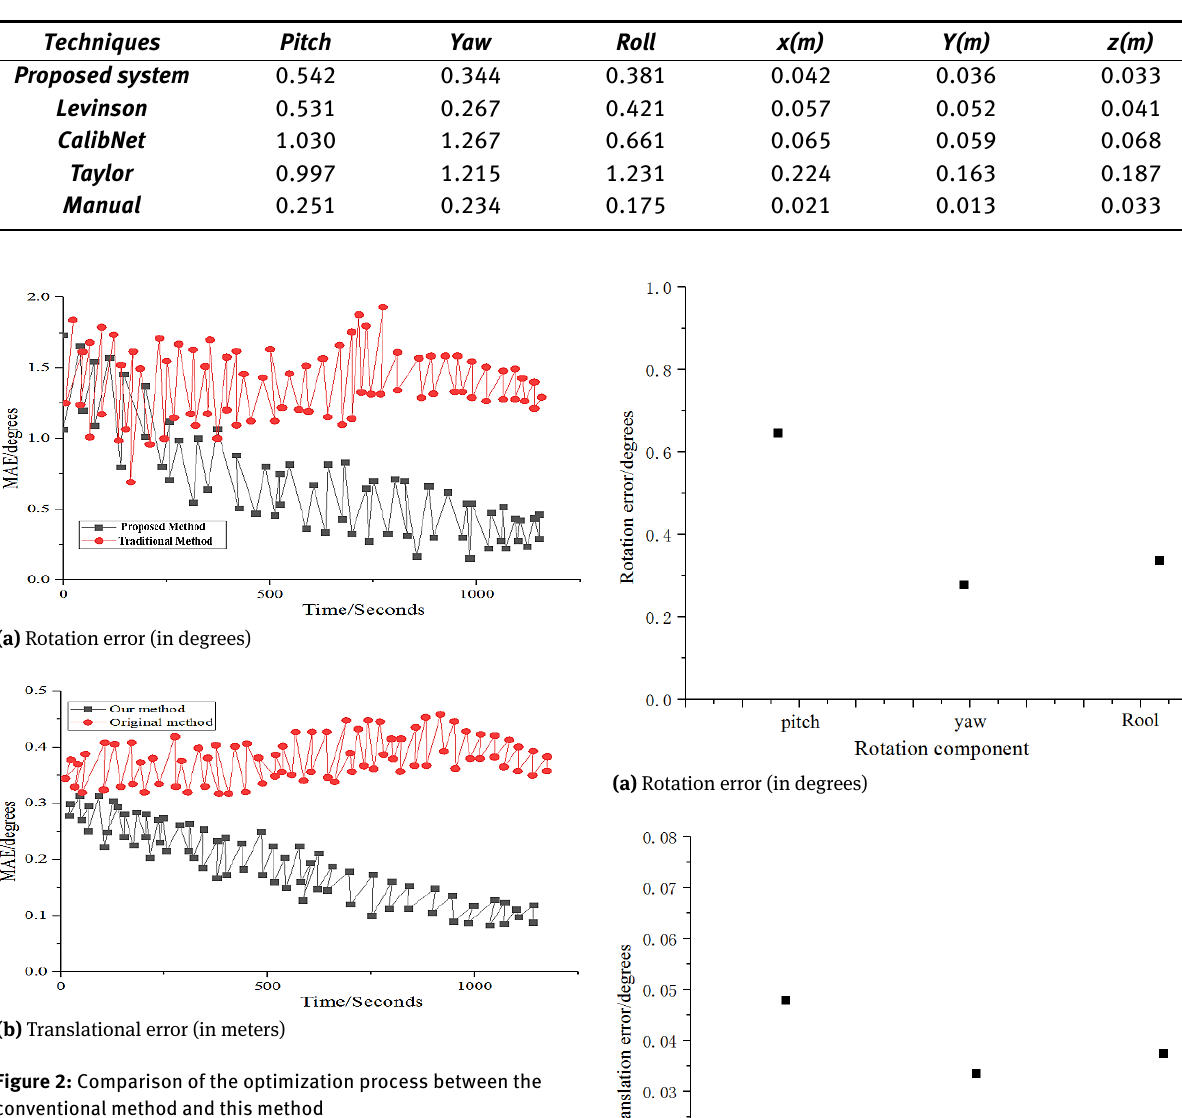
Figure 2: Comparison of the optimization process between the conventional method and this method